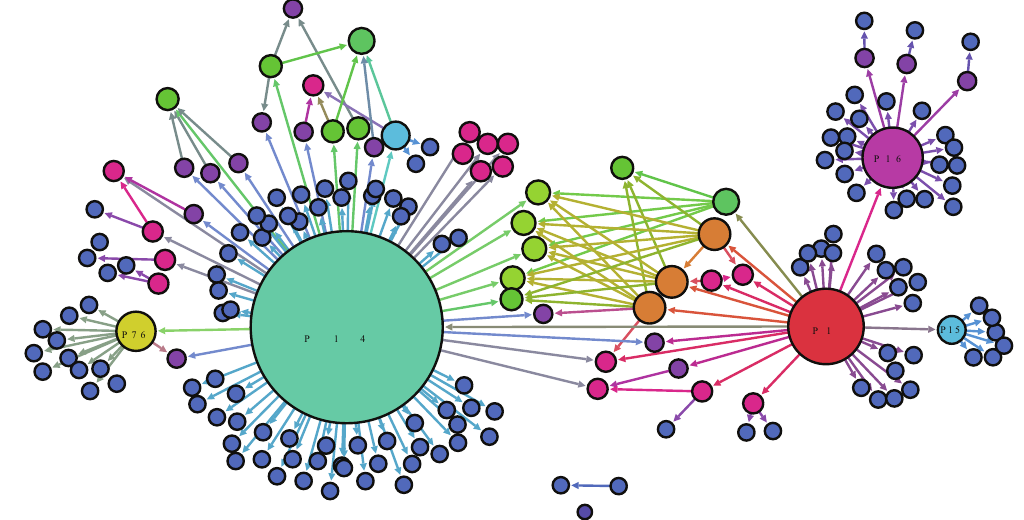
Figure 2. Transmission trees are displayed (only infection tracing shown). The node size is proportional to the number of secondary infection cases (five super-spreaders are